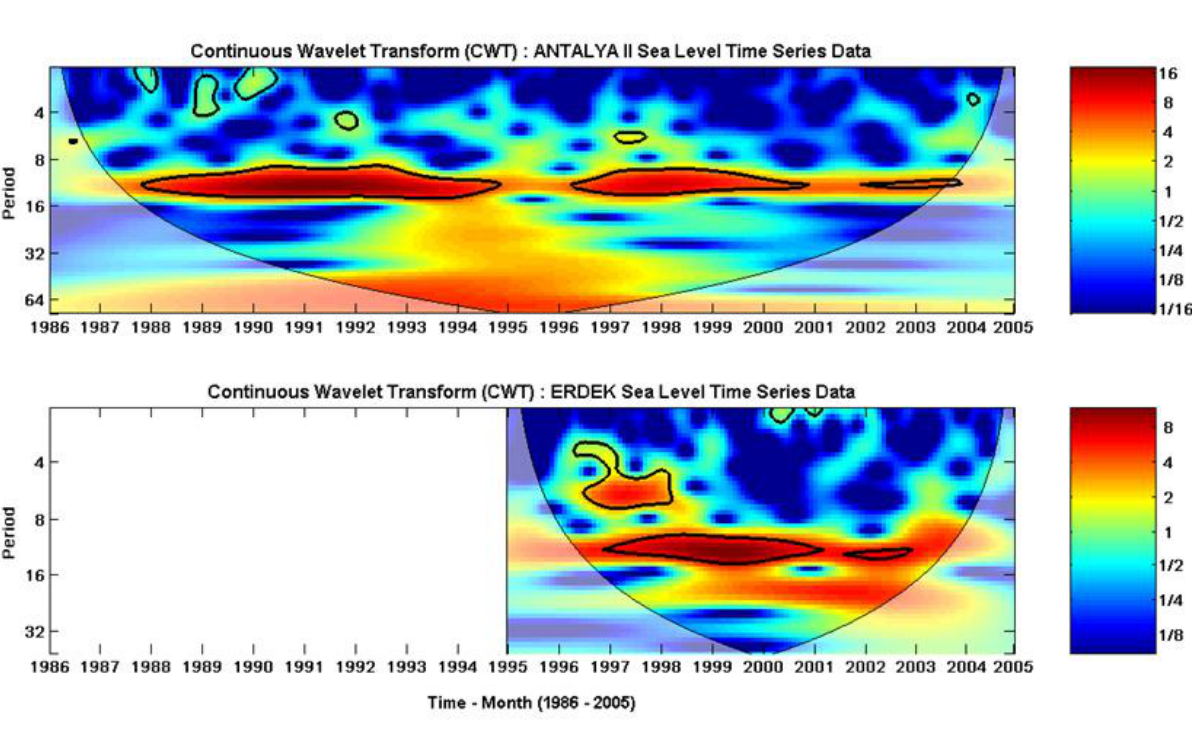
Figure 12. CWT power spectra of the monthly sea-level observations at the Antalya-II and Erdek tide gauges. The thick black contours indicate the 95% confidence level, and the region below the thin solid line indicates the cone of influence (COI), beyond which edge effects may distort the